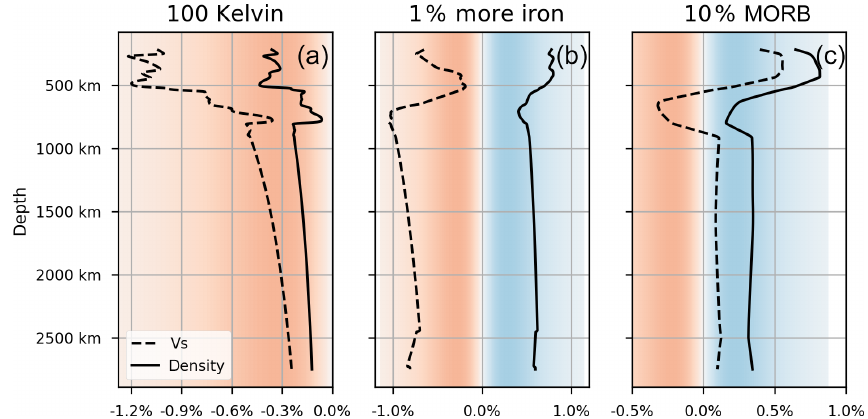
Figure A2. First-order perturbation curves for deviations from a adiabatic, hydrostatic model with pyrolitic composition. The red and blue background shading indicates negative and positive changes of the respective quantity. (a) Relative change for a temperature change of 100K. (b) Relative change for including 1% more FeO. (c) Relative change for a mixture of 90% pyrolite and 10%